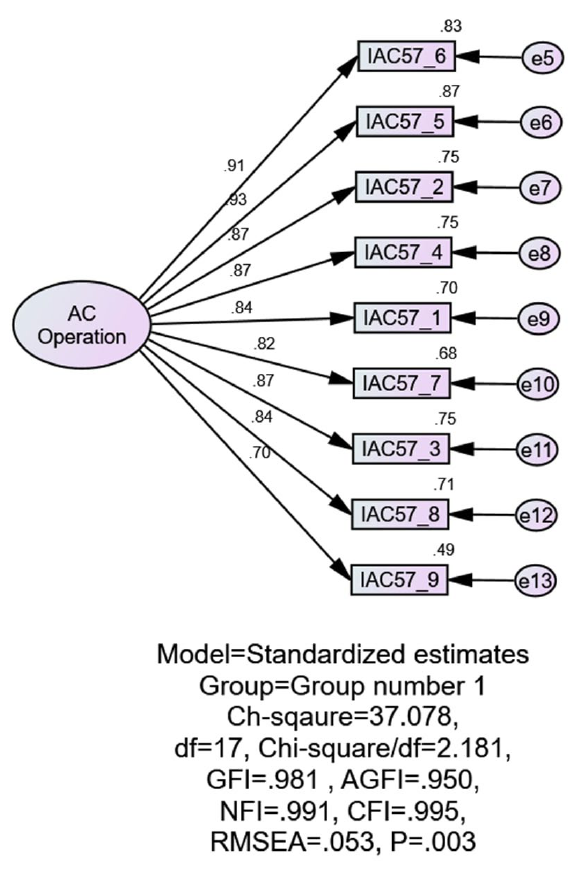
Figure A3. First-order factor model.